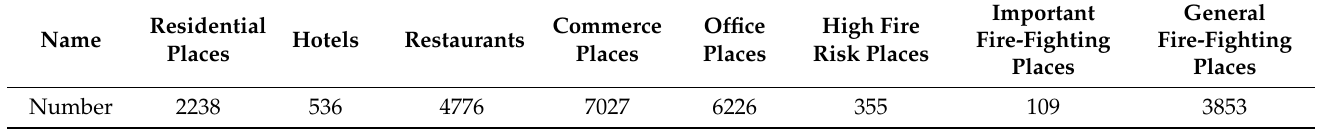
Table 1. The number of POIs in various